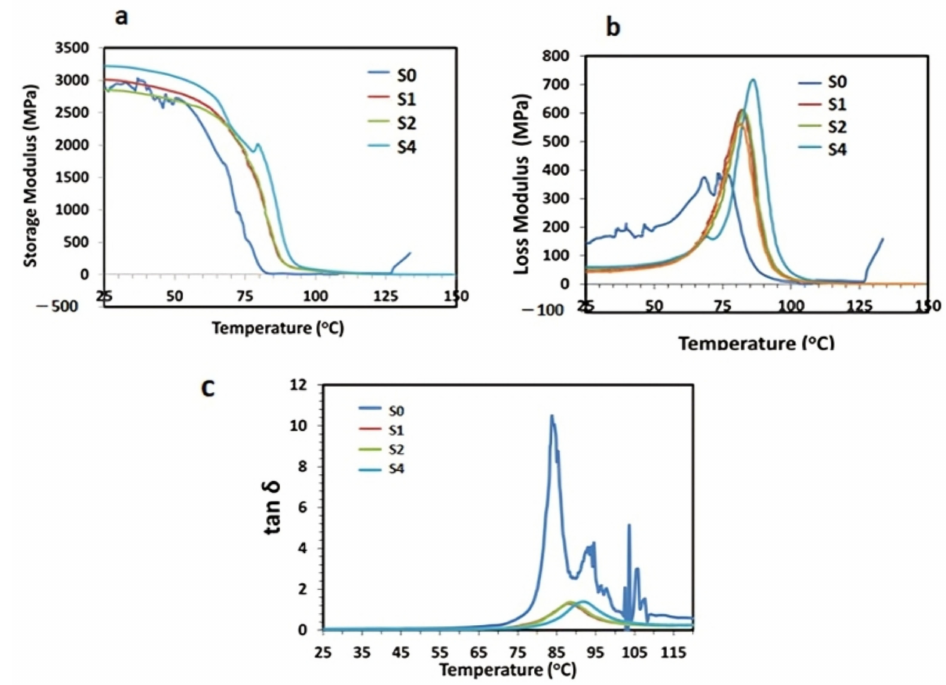
Figure 7. Dynamic mechanical analysis of pristine PS and PS/m-sepiolite nanocomposites: ( a ) Storage Modulus (E (cid:48)(cid:48) ); ( b ) Loss Modulus (E (cid:48)(cid:48) ); and ( c ) Damping Factor (tan δ